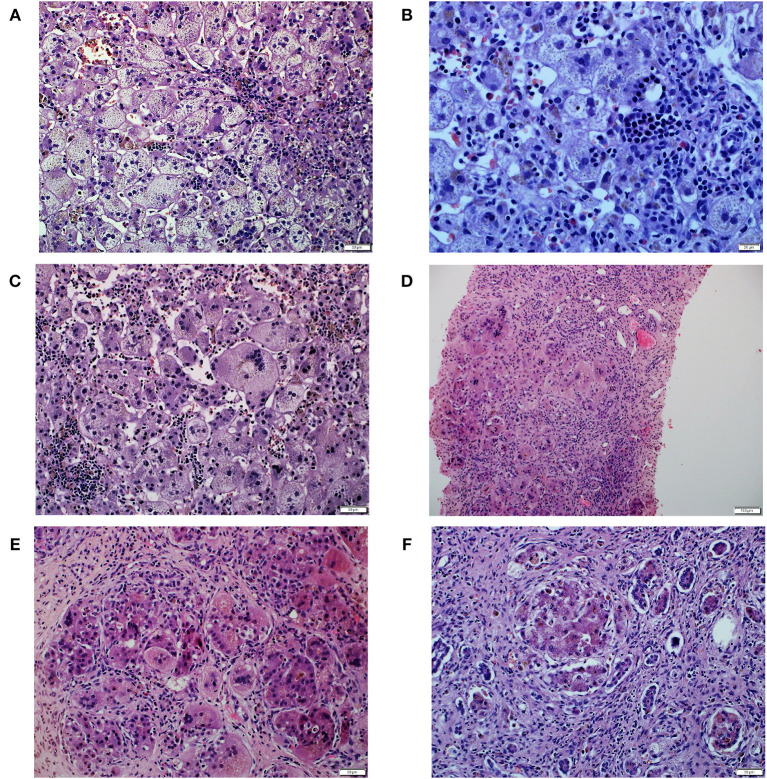
Histopathological liver features in Patient 1. (A) Diffuse inflammatory infiltrates composed of lymphoid cells, in the portal tracts. (B) Abundant foci of extramedullary heamatopoiesis in the sinusoids. (C) Multinucleated giant hepatocytes and hepatic rosettes with bilirubinostasis. (D) Multinucleated giant cells were inside cirrhotic nodules. (E) Intracellular cholestasis with non-specific inflammatory infiltrates composed of neutrophils and lymphocytes in the fibrous septa. (F) Late cirrhosis with only small remnants of liver cells surrounded by fibrous tissue.